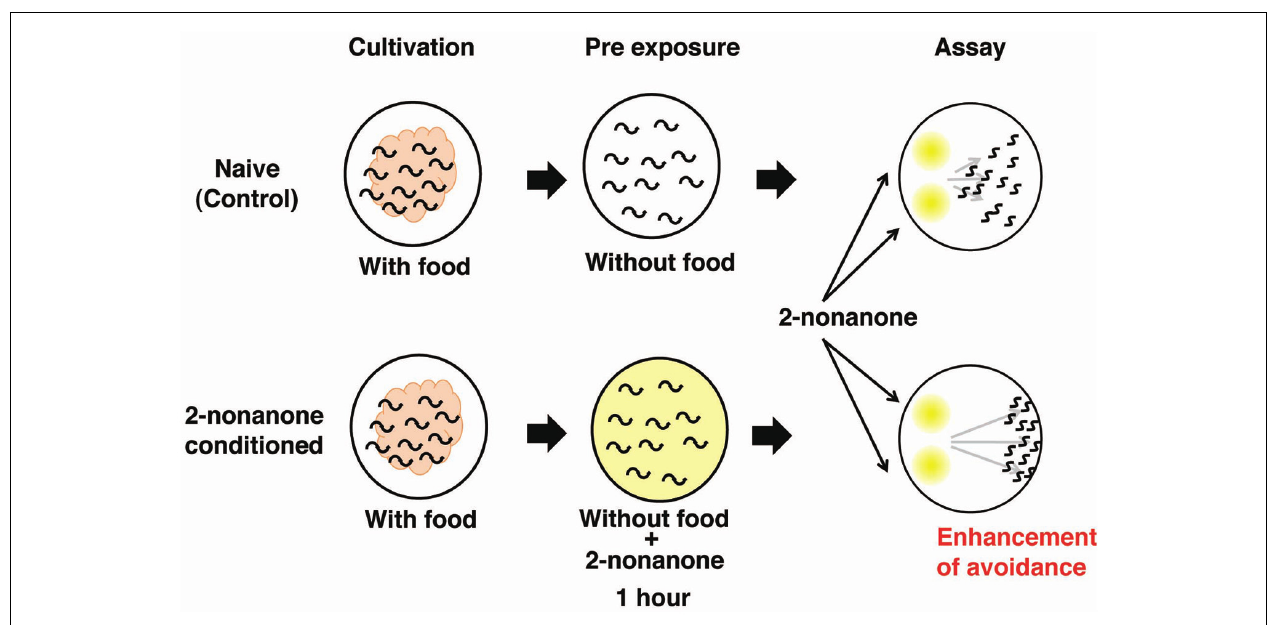
FIGURE 4 |The enhancement of avoidance behavior after the exposure to 2-nonanone (Kimura etal., 2004). Scheme for experiments and the image for